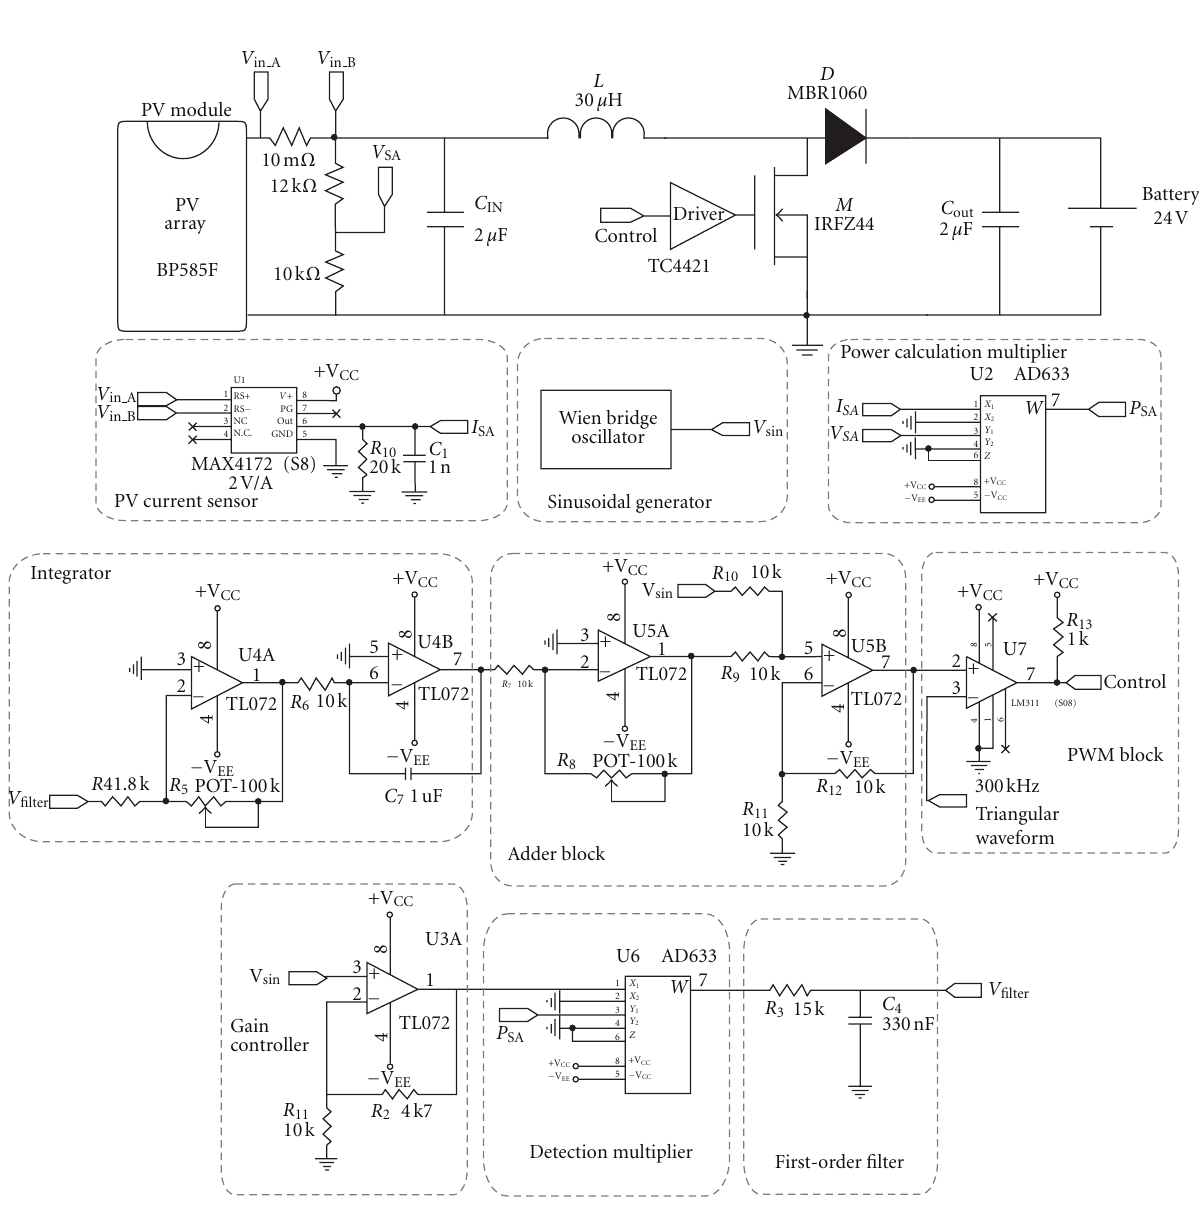
Figure 5: Prototype of PV generator with MPPT based on sinusoidal